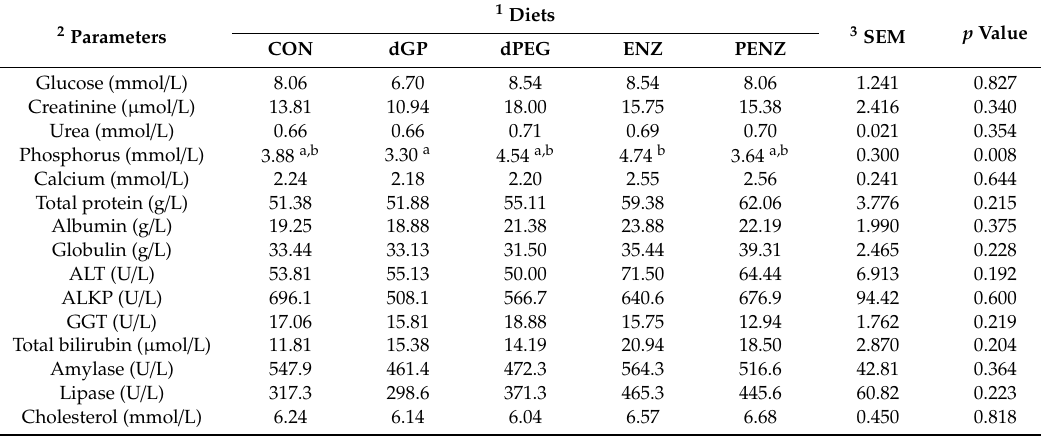
Table 5. E ff ect of treating red grape pomace with polyethylene glycol and a cellulolytic enzyme mixture on serum biochemical parameters of broiler